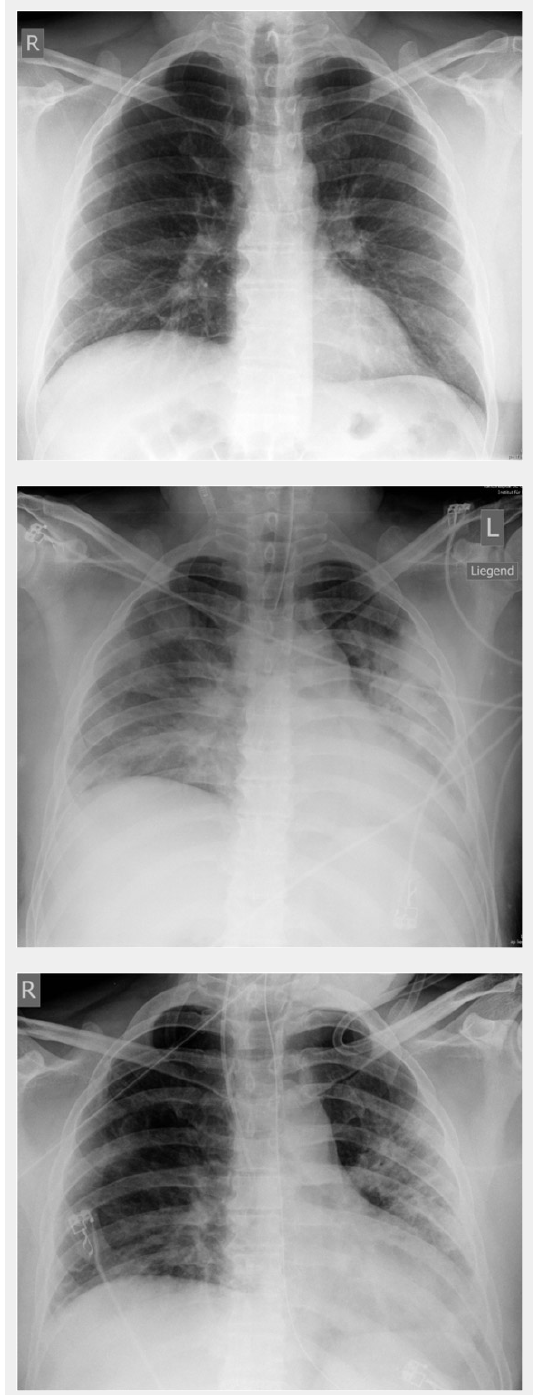
Figure 1 X-ray course of patient A. Left, normal chest x-ray (p.a., erect) at admission. Center, chest x-ray (p.a., supine) on day 4, showing massive infiltration. Right, chest x-ray (p.a., supine) day 14, after 10 days on oseltamivir and 5 days on steroids, showing regression of